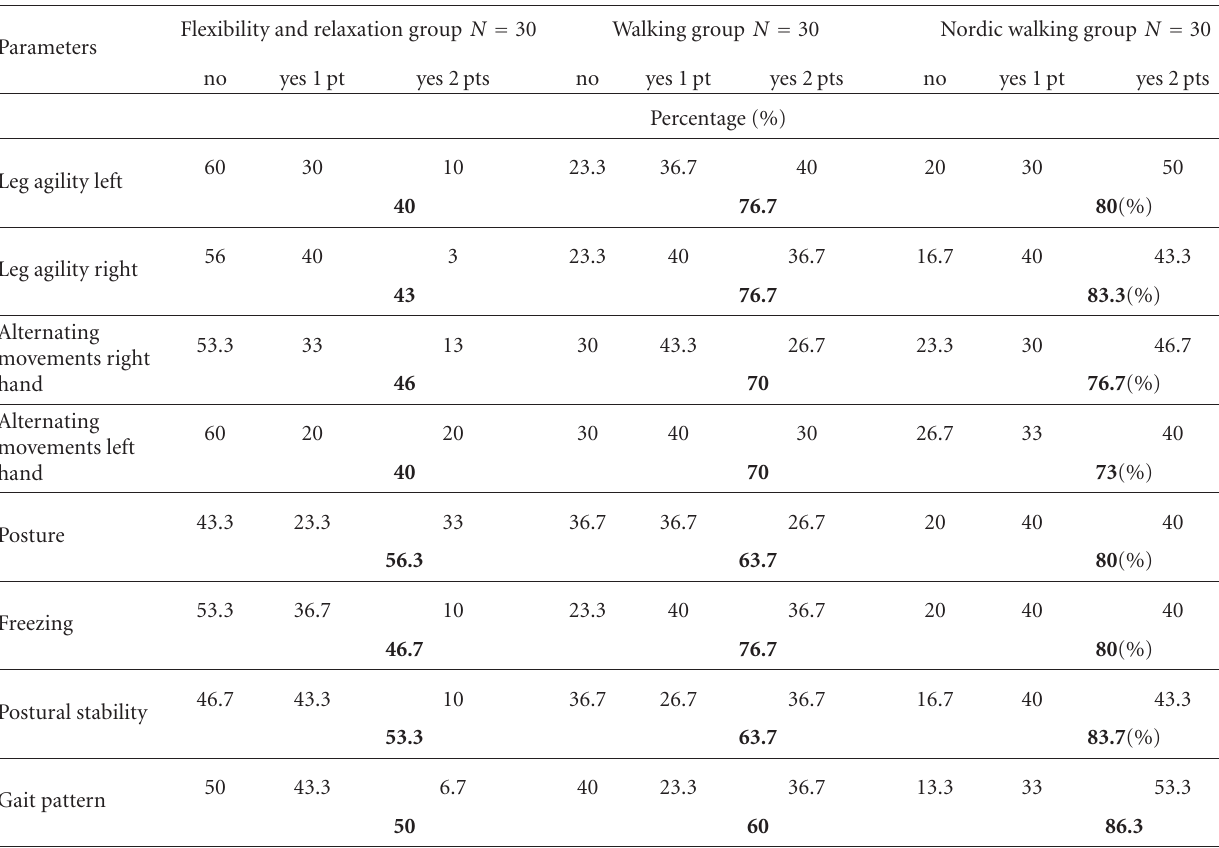
Table 4: Comparison of improvement in leg agility, alternating hand movements, posture, postural stability, freezing, and gait pattern between the training